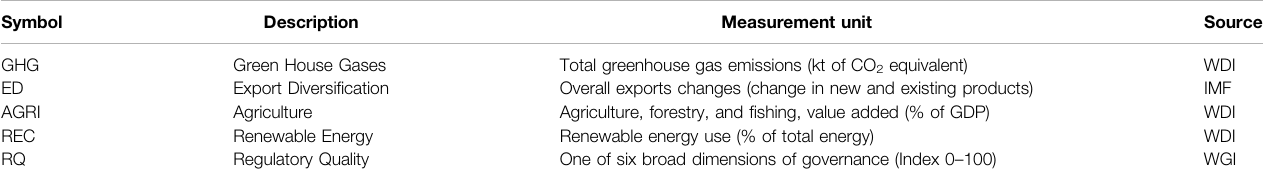
TABLE 1 | Variables of the